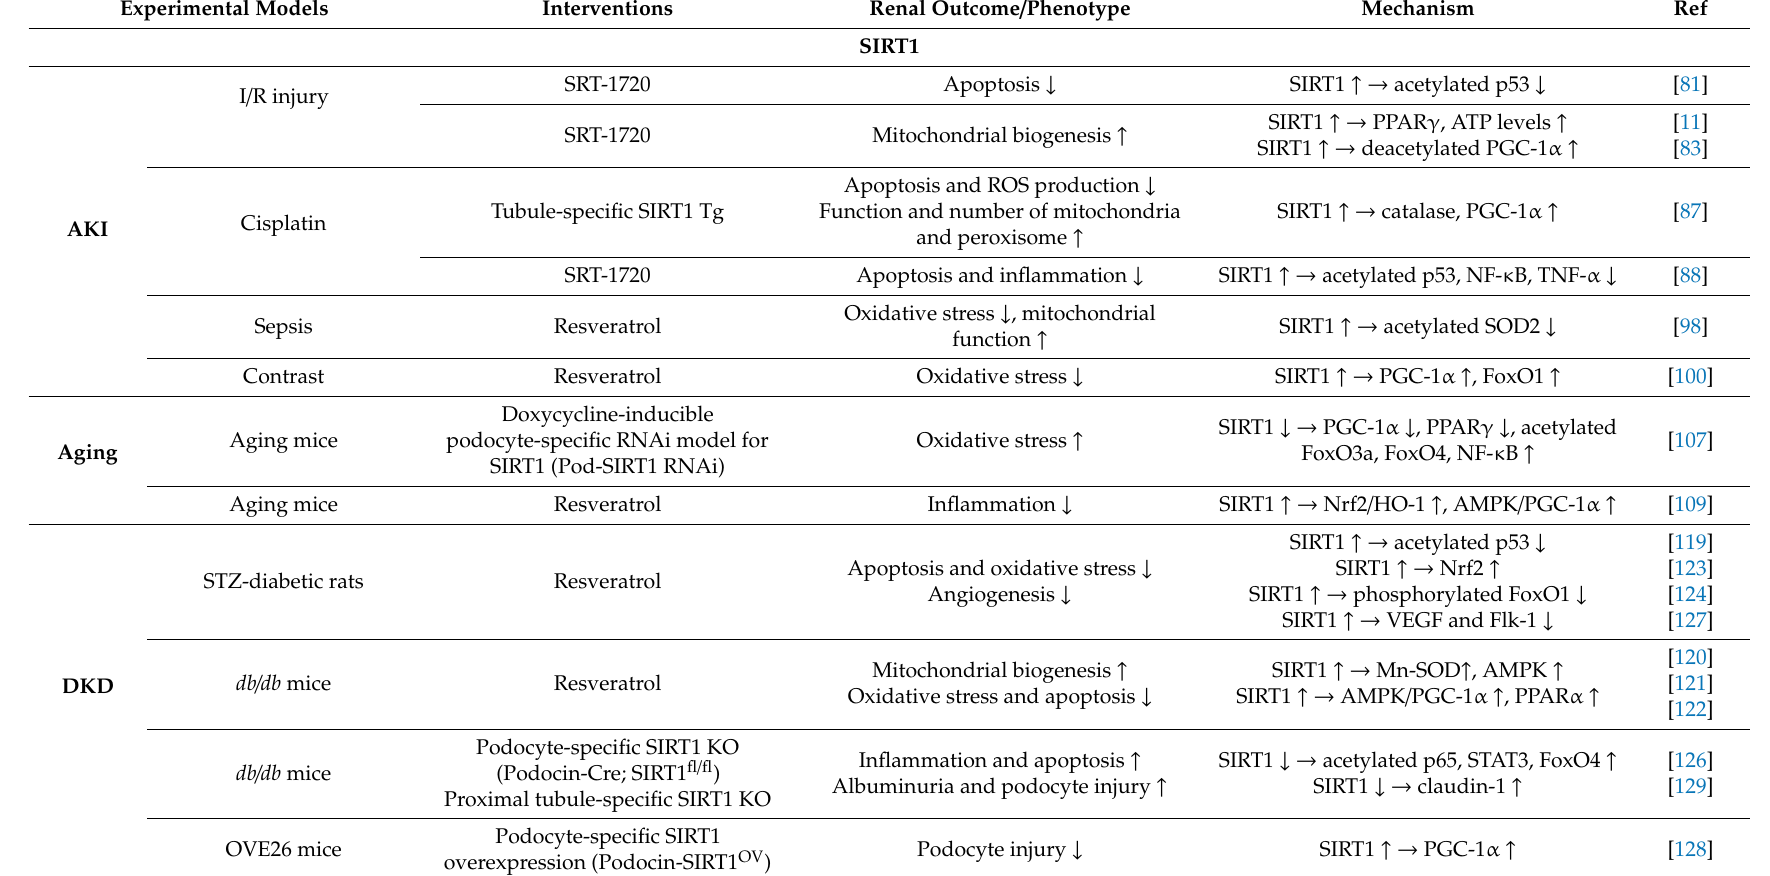
Table 1. Pathophysiologic role of sirtuins in kidney diseases ( ↓ : decreases, ↑ :